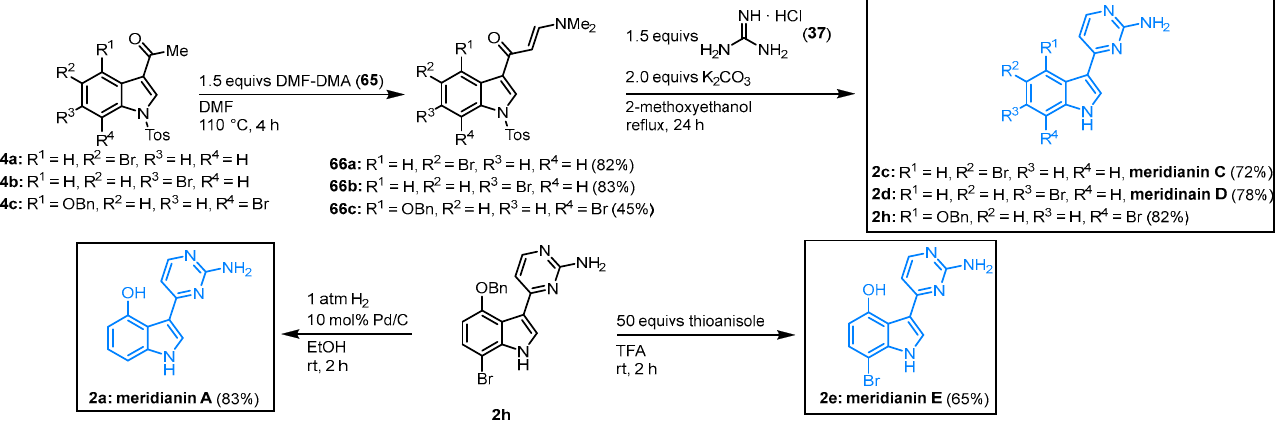
Figure 14. Synthesis of meridianins A, C, D and E by Molina and Fresneda